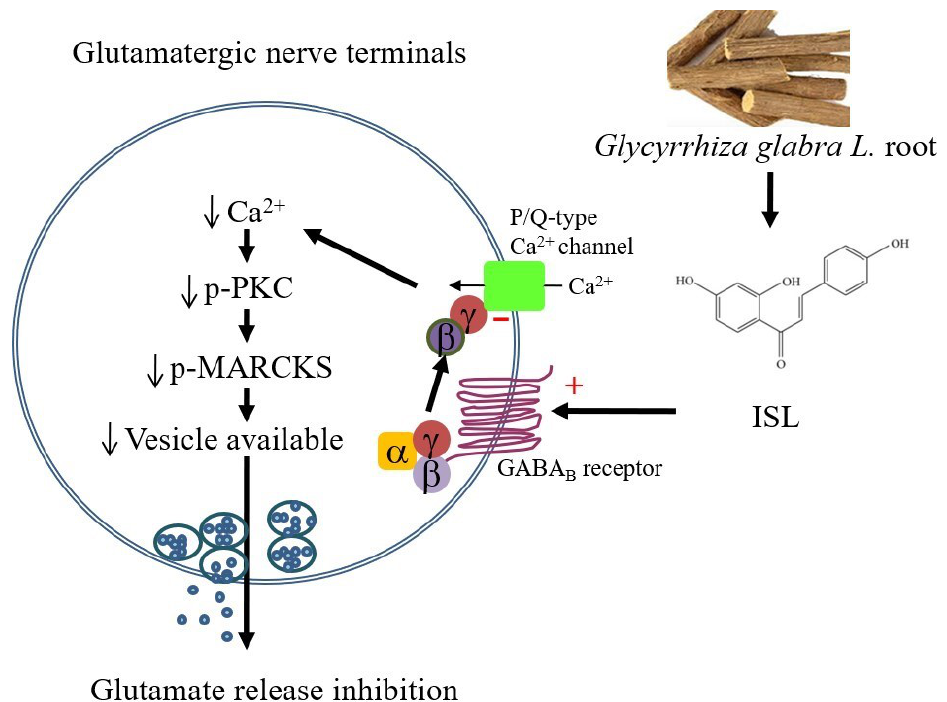
Figure 7. Schematic representation of the main mechanism involved in ISL-mediated inhibition of glutamate release from cerebrocortical nerve terminals. Gi βγ , Gi protein βγ subunits; PKC, protein kinase C; MARCKS, myristoylated alanine-rich C kinase substrate.